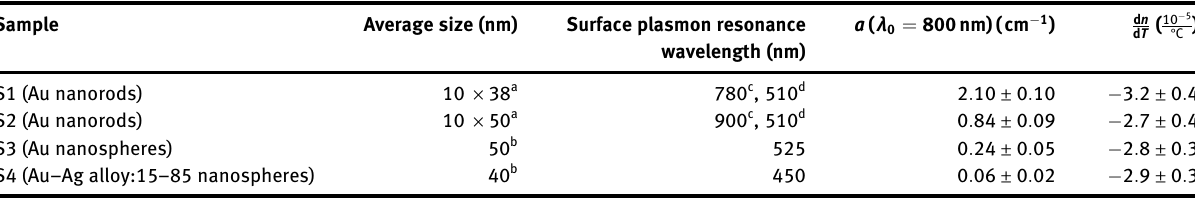
Table  : Linearabsorptionandthermo-opticcoef fi cientsoftheexaminedplasmonicnanocolloids,characterizedbyopticaltransmittanceand